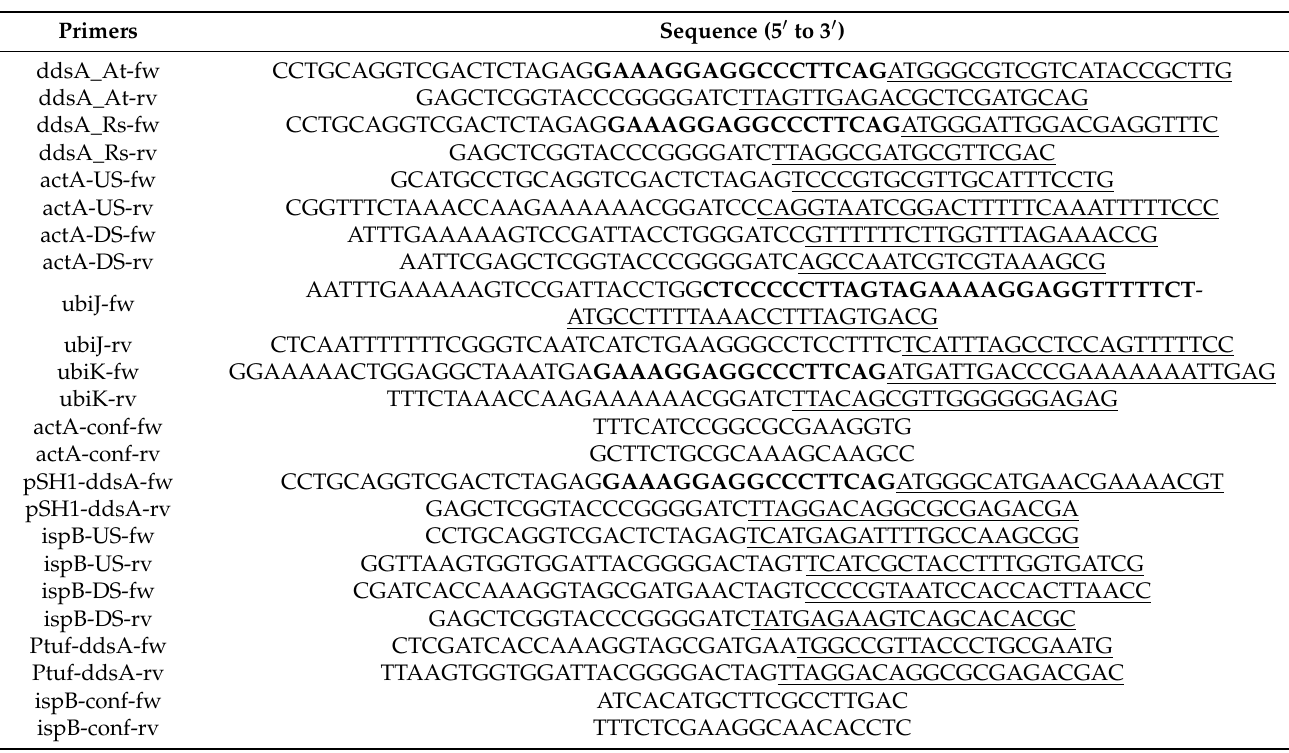
Table 6. Primers used in this